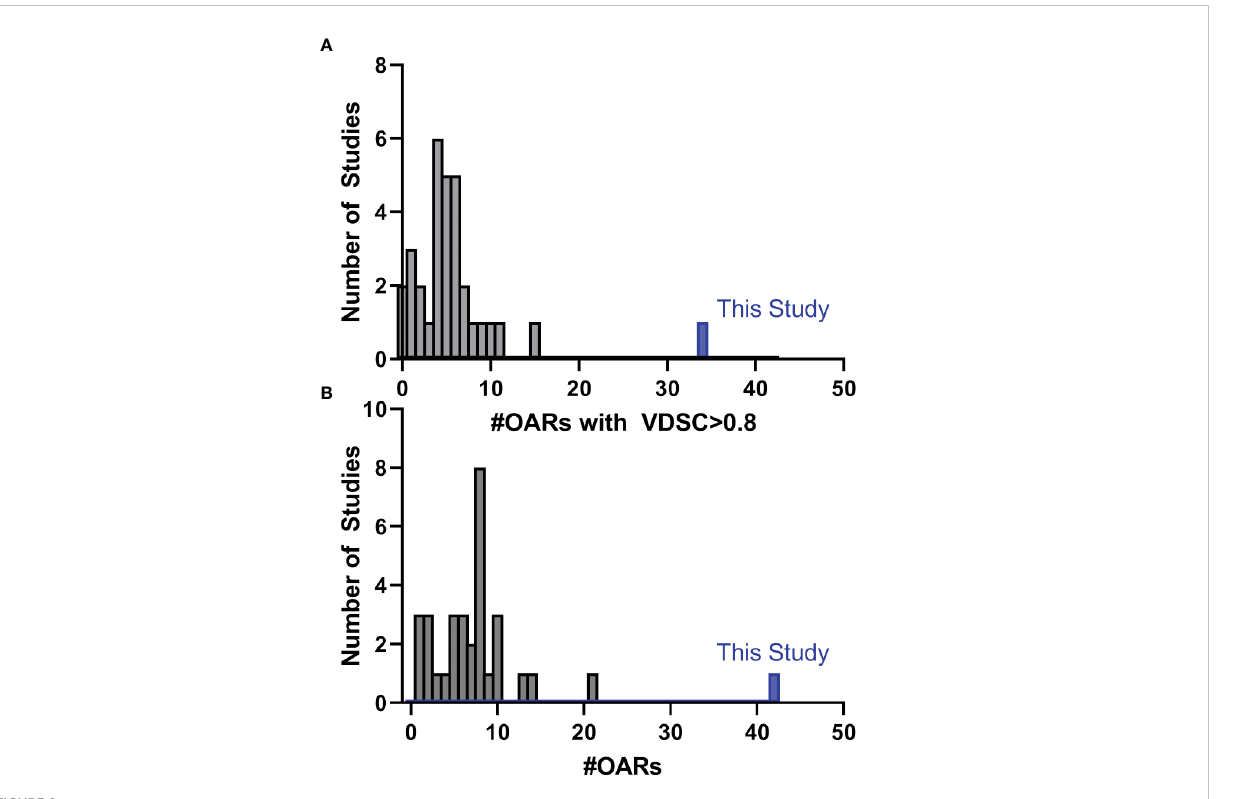
FIGURE 9 Histogram showing the number of studies found during the literature that reported the number of distinct OARs (of those used in this study) that had (A) a mean VDSC greater than 0.8 or (B) the total number of OARs included in the study that corresponded with those in this study. Detailed discussion is given in section 5 of the Supplemental